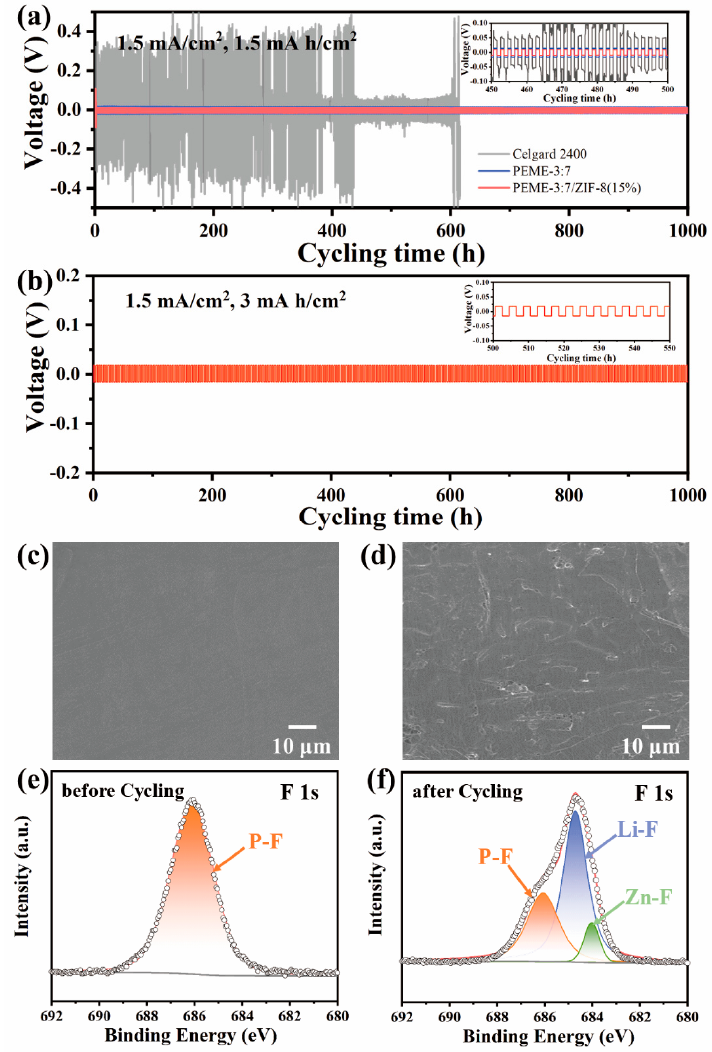
Figure 6. Voltage curves of ( a ) Li||Celgard 2400||Li, Li||PEME-3:7||Li, and Li||PEME-3:7/ZIF- 8(15%)||Li at current density of 1.5 mA/cm 2 for 1.5 mA h/cm 2 ; ( b ) Li||PEME-3:7/ZIF-8(15%)||Li at current density of 1.5 mA/cm 2 for 3 mA h/cm 2 . Surface SEM image of ( c ) pristine Li sheet; ( d ) Li anode of Li||PEME-3:7/ZIF-8(15%)||Li after 500 cycles at 1.5 mA/cm 2 current density. XPS spectra of F 1s ( e ) before and ( f ) after PEME-3:7/ZIF-8(15%) membrane cycling.